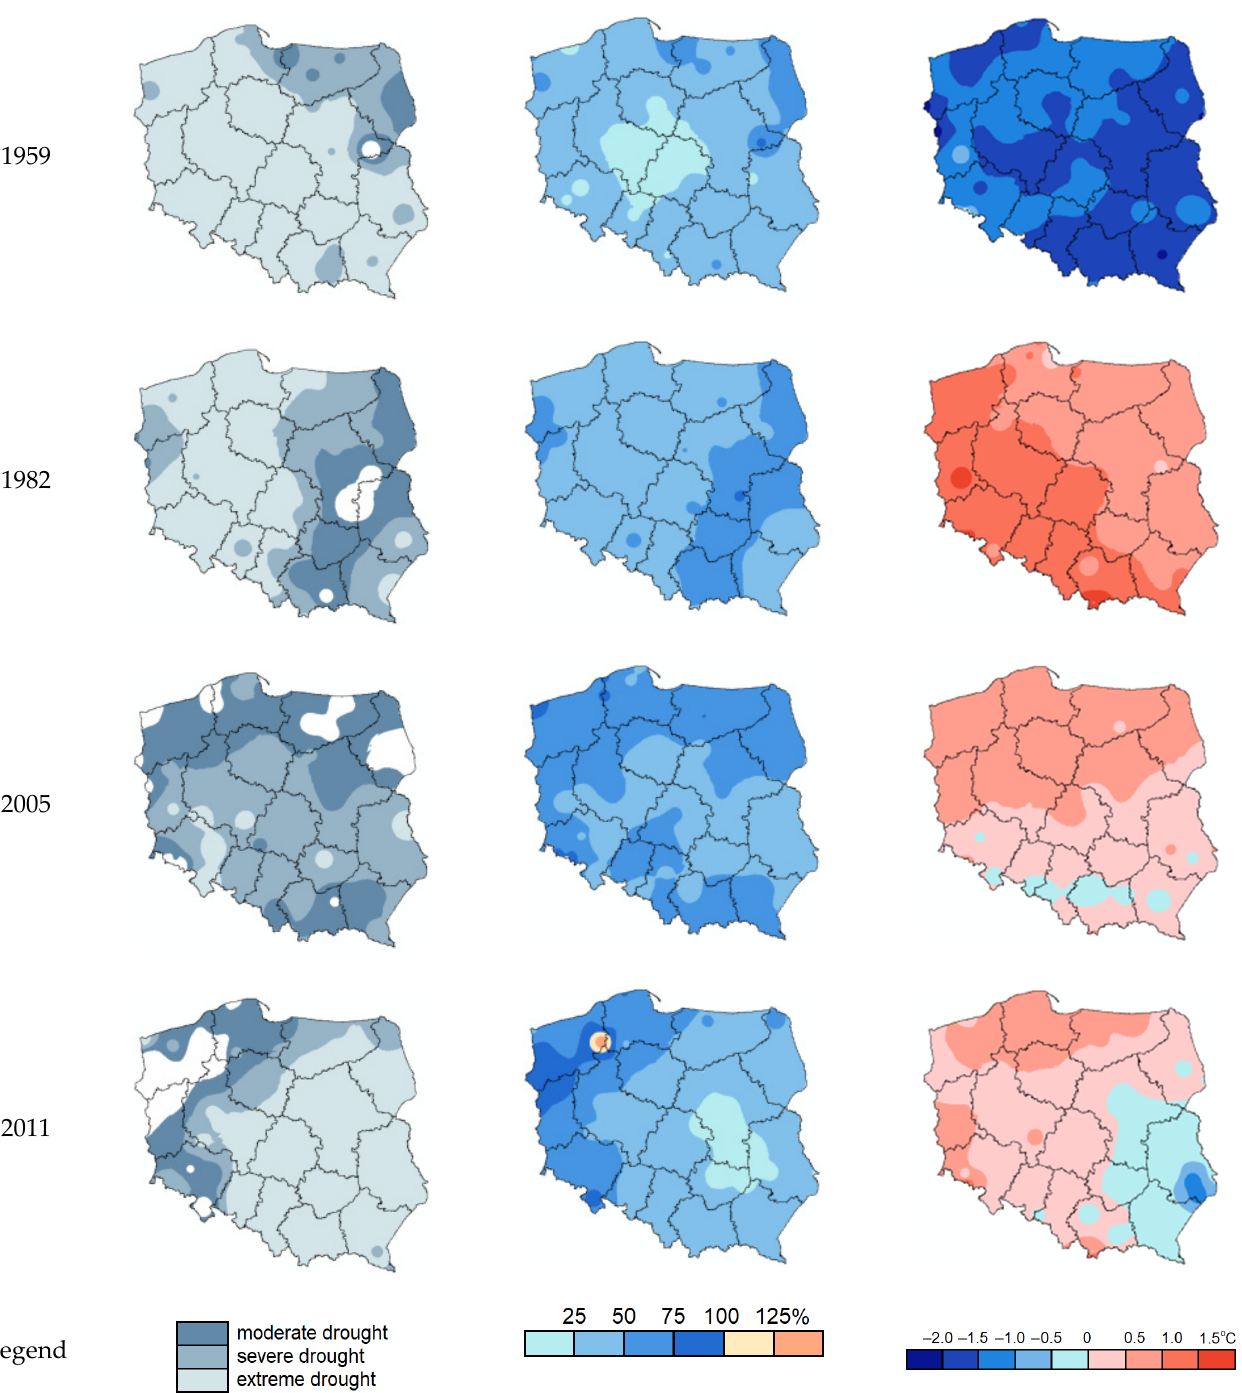
Figure 5. Spatial distribution of SPI-3 , Δ Pr and Δ Ta in Poland in autumn in the years when the SPI-3 value for a given area was ≤− 2 (1951, 1959, 1982, 2005 and 2011). Notes as in Figure 3. The monitoring of MDr and consequently the assessment of its impact on agriculture takes into account not only the intensity but also the frequency of this phenomenon. The frequency of meteorological drought is not uniform across Poland and depends on the season (Figure 6). In spring, MDr identified on the basis of SPI-3 occurred most frequently in north (from 30% to 35%) and east Poland (from 25% to 30%); in summer, drought was identified mainly in north and central-west Poland (from 15% to 20%); in autumn, drought occurred primarily in northwest and south Poland (from 20% to